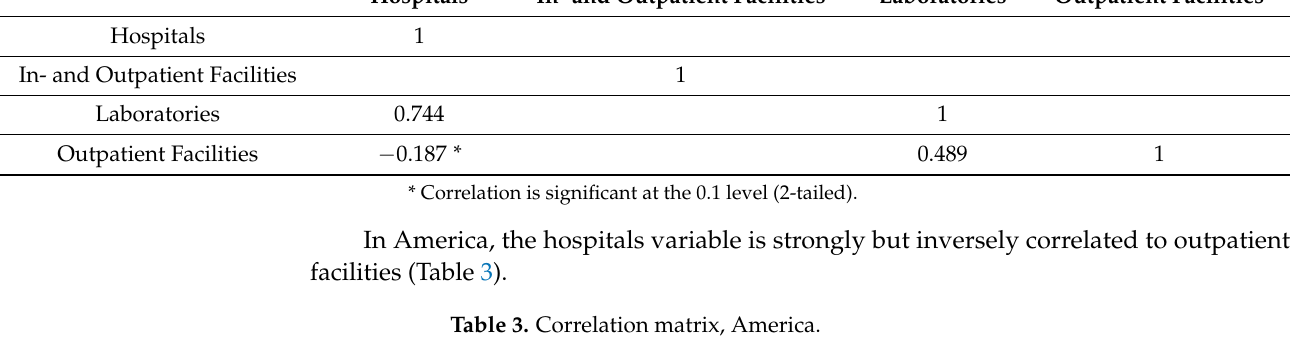
Figure 9. Number of surveillance sites, Western Pacific, 2017–2020.